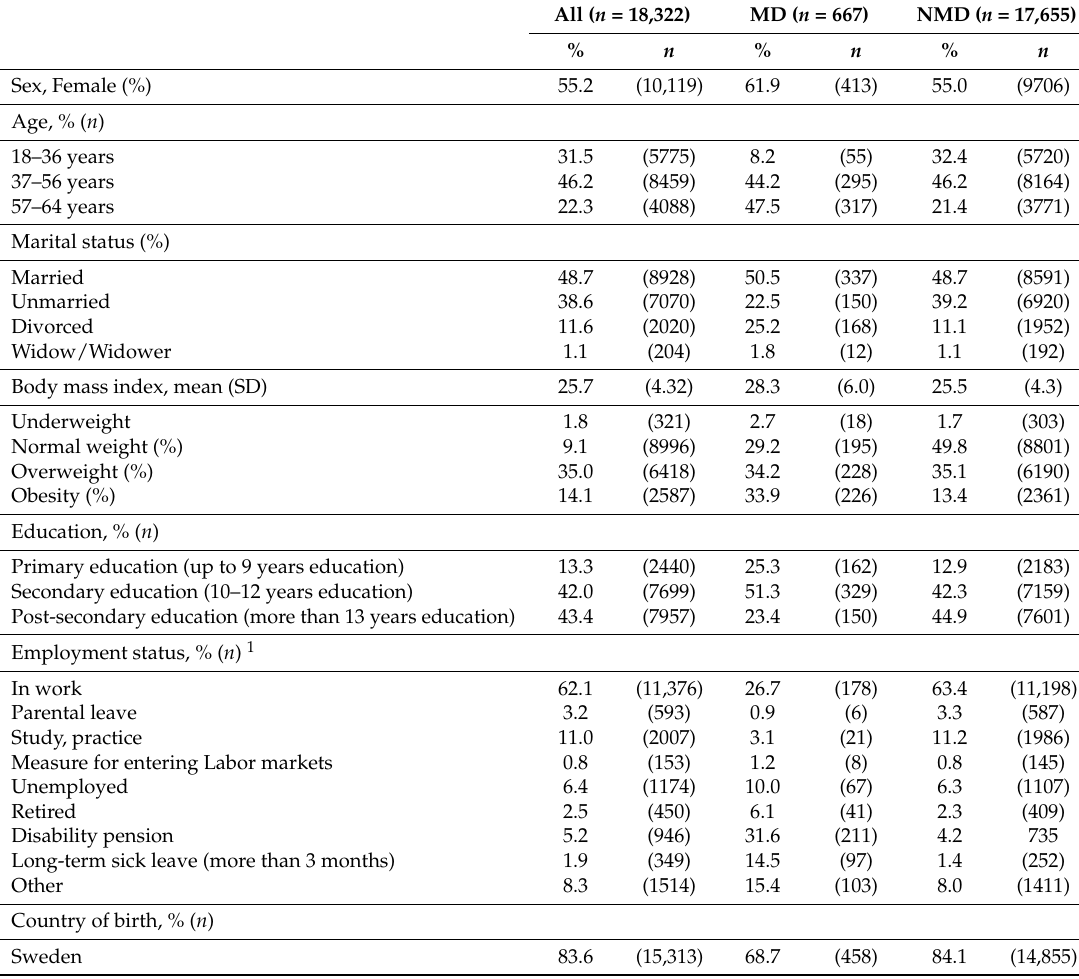
Table 1. Population characteristics n =